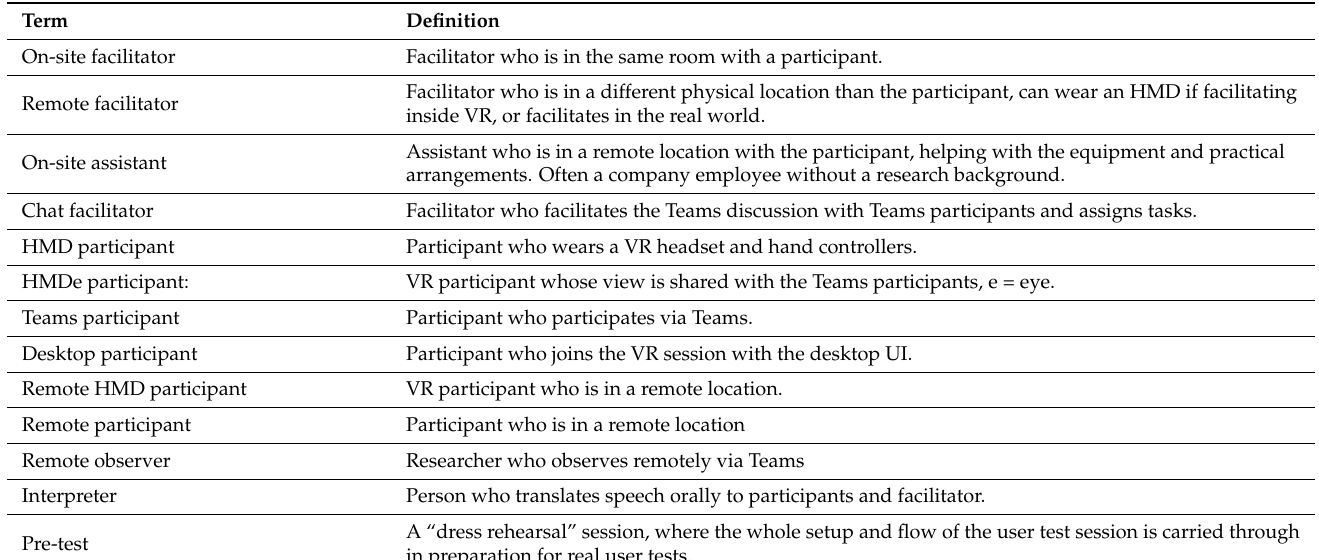
Table 2. Description of terms used in this